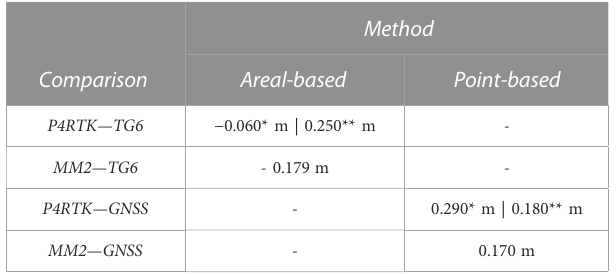
TABLE 7 Summary of the results obtained from the different comparisons. The values signed with * and ** refer to the target-less and target-based approach